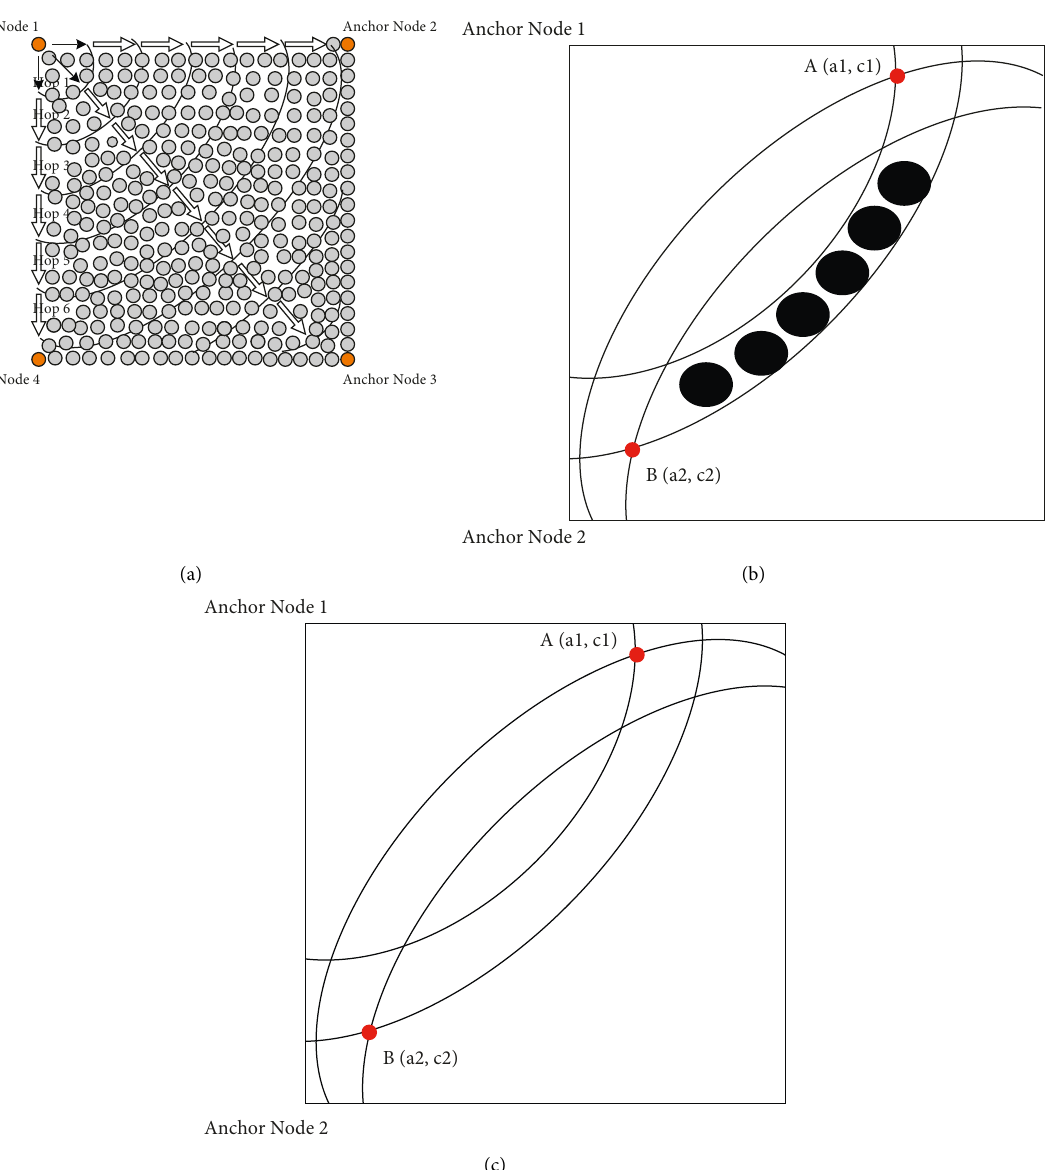
Figure 8: (a) Coordination system setup in CORONA protocol. (b) The doted area is the area in which coordinates are between node 1 and node 2. (c) Facing anchor points may not complete the